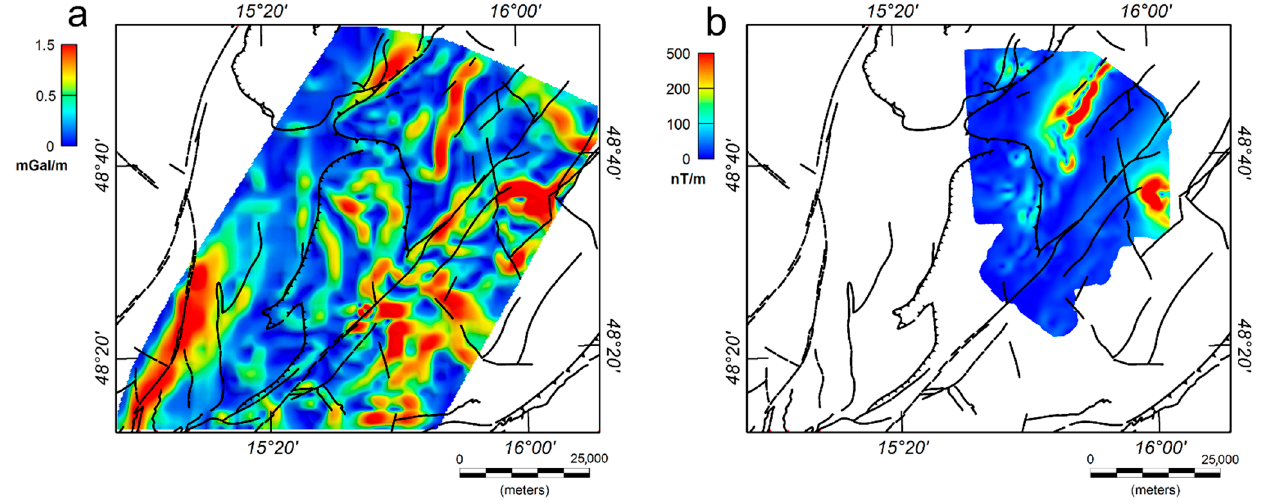
Figure 7. EHD map of the survey area: ( a ) Medium-scale EHD map of gravity data obtained using derivatives of order up to p = 6; ( b ) medium-scale EHD map of aeromagnetic data obtained using derivatives of order up to p = 6.